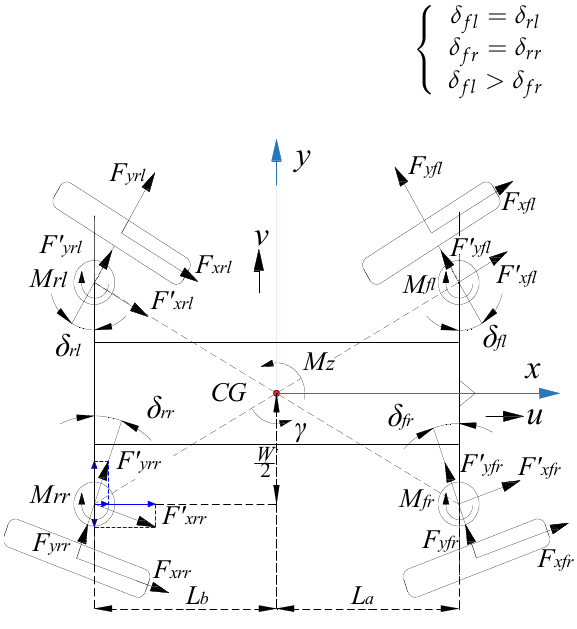
Figure 4. Simplified free body diagram of the robot chassis. F xi is the longitudinal tire force of each wheel (N), F yi represents the lateral tire force (N), M Z denotes the yaw moment generated by the four wheels (N·m), CG is the center of chassis gravity, and γ is the yaw rate (deg·s − 1 ). i = 1( fl ), 2( fr ), 3( rl ), 4( rr ) denote the left front, right front, left rear and right rear wheel of the robot chassis, respectively. In Figure 4, when F xi and F yi are transferred to the off-center axis, F (cid:48) xi , F (cid:48) yi and M Zi are formed. Thus, in this dynamic model, the kinetic equations of the lateral, longitudinal and yaw motion of the robot chassis are expressed in Equations (7)–(9),